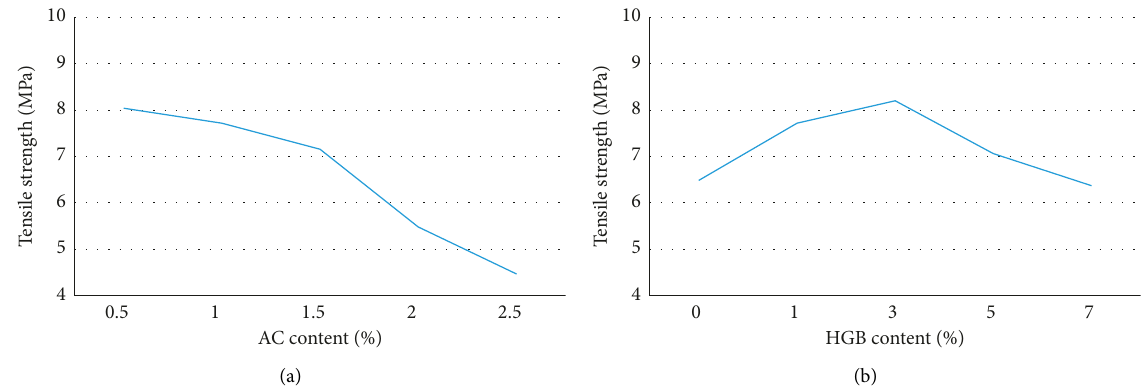
Figure 10: Tensile strength diagram of foamed samples with different AC and HGB contents. (a) The effect of different AC content on the tensile properties of the sample. (b) The effect of different HGB content on the tensile properties of the